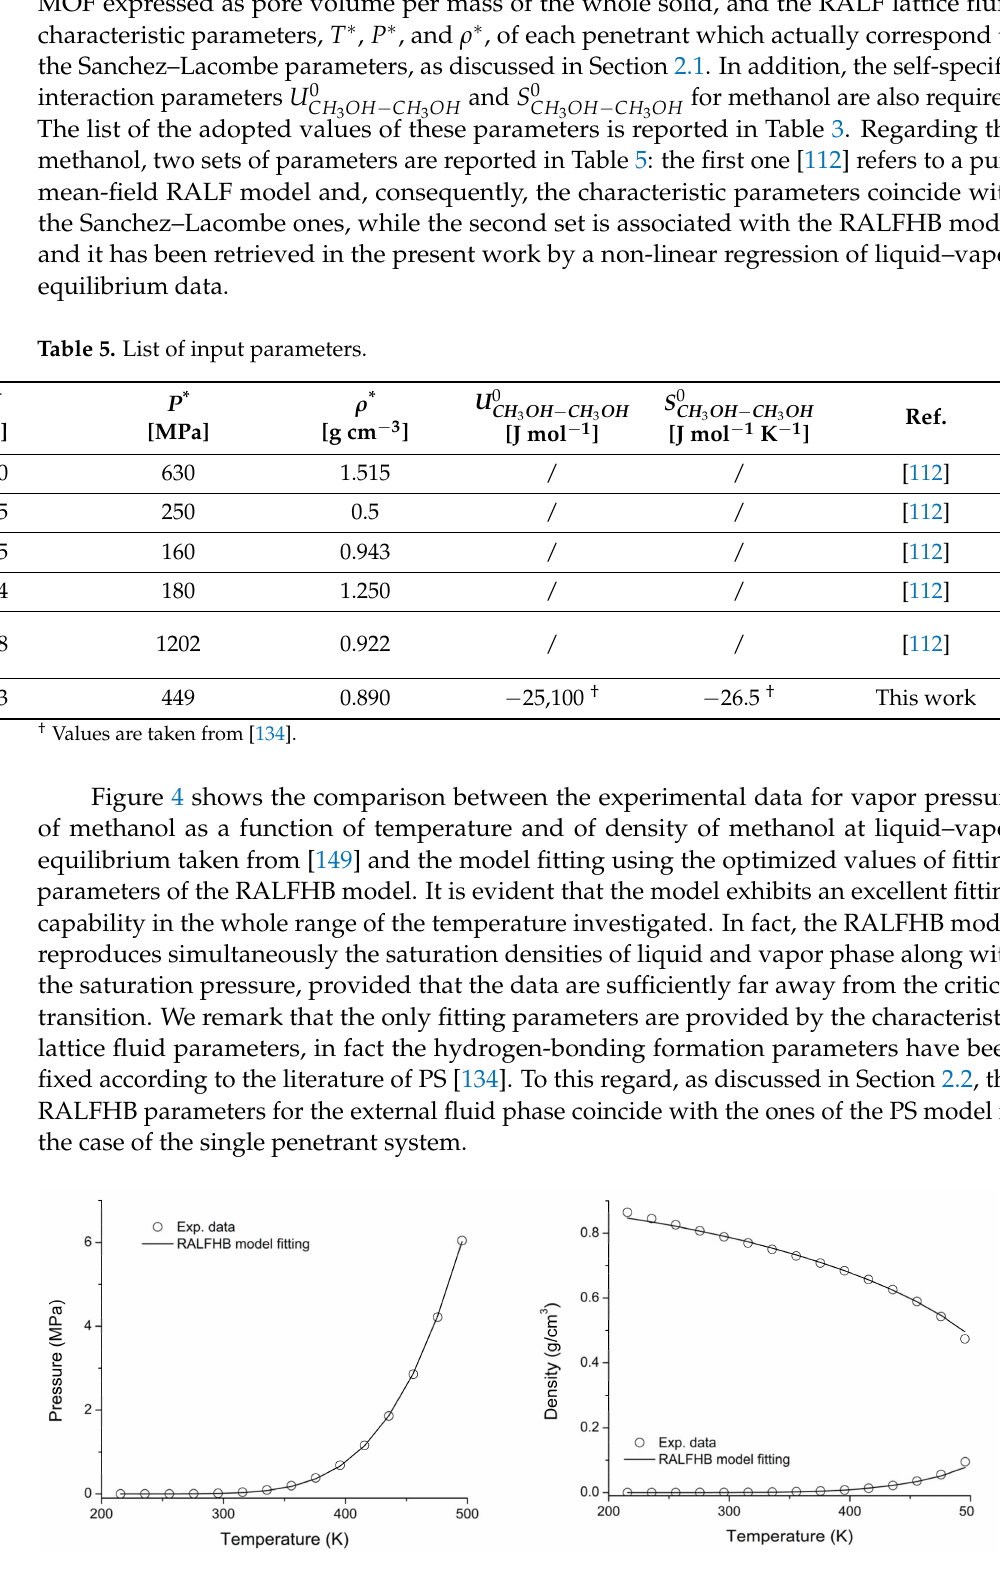
Figure 4. Liquid–vapor equilibrium of methanol: comparison between experimental data [149] and RALFHB model